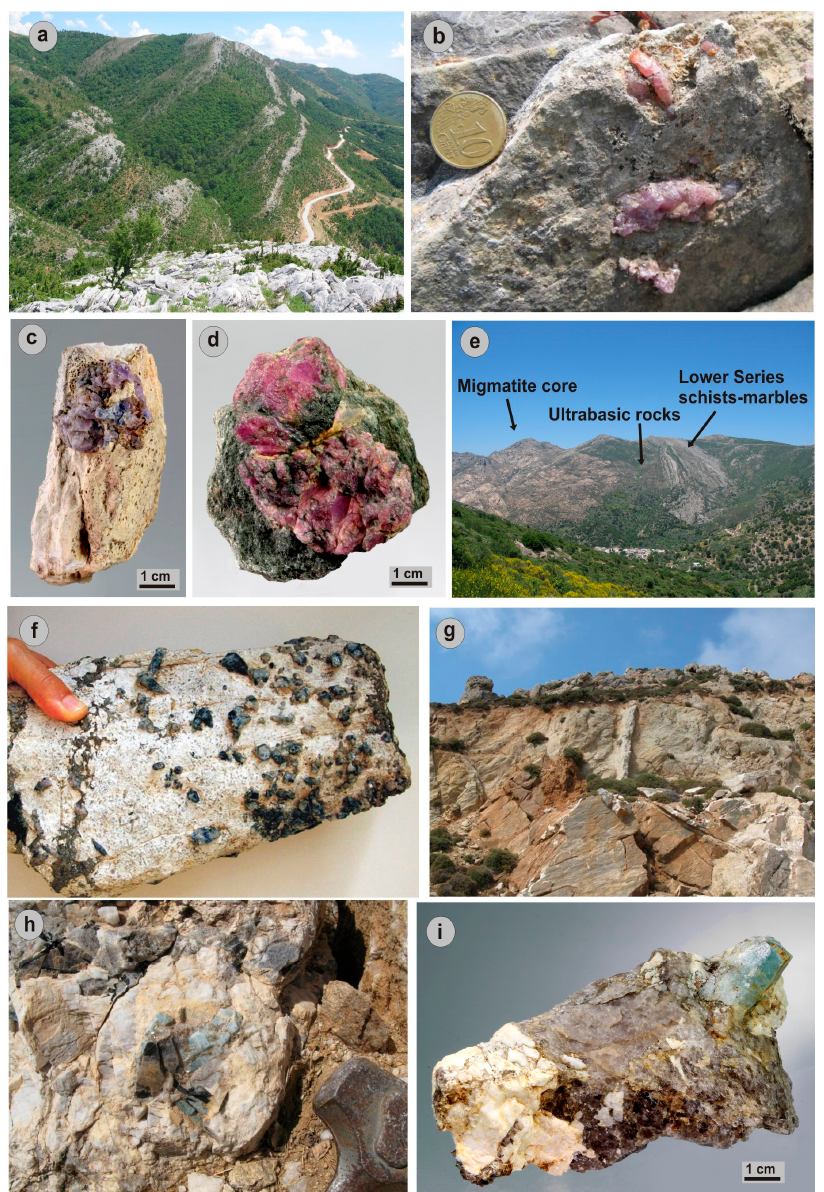
Figure 3. Field and hand specimens photographs demonstrating gem corundum and beryl occurrences / crystals from Greece: ( a ) Corundum-bearing marbles alternating with amphibolites along the Nestos suture zone, Gorgona / Xanthi area; ( b , c ) Pink to purple sapphires within Xanthi marbles; ( d ) Ruby within pargasite schist from Paranesti / Drama; ( e ) Ultrabasic bodies rimming the migmatite core of Naxos Island. Plumasite formation took place after metasomatic reaction between ultrabasites and pegmatites, ( f ) Blue and colorless sapphires within desilicated pegmatite (plumasite) from Kinidaros, Naxos Island; ( g ) Beryl-bearing pegmatite penetrating migmatite at Kinidaros, Naxos Island, ( h , i ) Blue beryl (var. aquamarine) associated with orthoclase and muscovite within pegmatite from Kinidaros, Naxos Island. Photographs 3 c,d,i are courtesy of Berthold Ottens. On Ikaria Island, blue sapphires occur in the metabauxites of Atheras Mt, hosted within marbles, which lie on top of gneisses. The corundum megacrysts fill together with margarite, extensional fissures and networks of veins discordant to the metabauxite foliation [18,37]. The corundums are deep-blue in color, tabular to well-shaped, reach sizes up to 4 cm and are accompanied by Fe-chlorite,